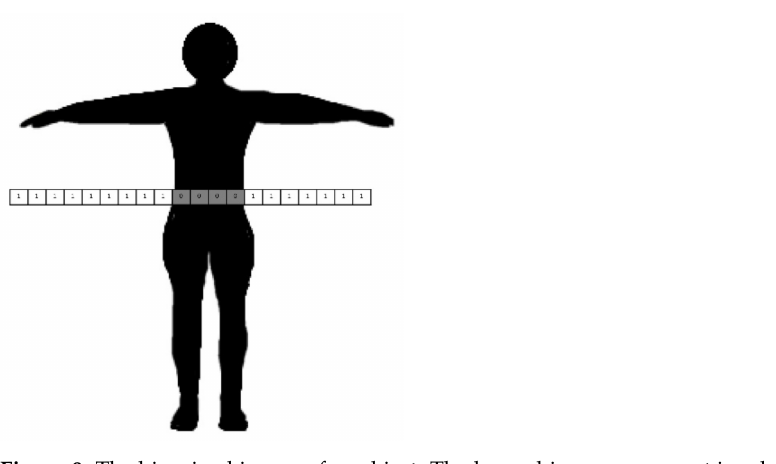
Figure 9. The binarized image of a subject. The lower hip measurement is calculated by the area in